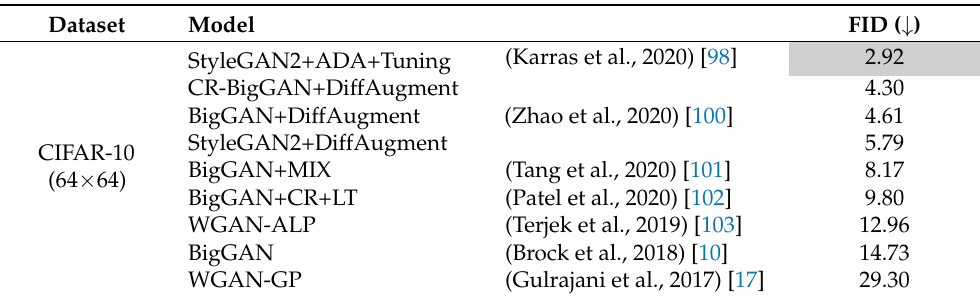
Table 8 is the FID of 9 models trained on the CIFAR-10 dataset. Application models incorporating the latest techniques such as Adaptive Discriminator Augmentation (ADA), Consistency Regularization (CR), Differentiable Augmentation (DiffAugment), training MIXture (MIX), Latent Transformation (LT) and Adversarial Lipschitz Regularization (ALP) with StyleGAN, BigGAN, and WGAN were also added to the comparison items [98–103]. Table 8. The FIDs of different models trained on the CIFAR-10 dataset. The lower the FID value, the better the